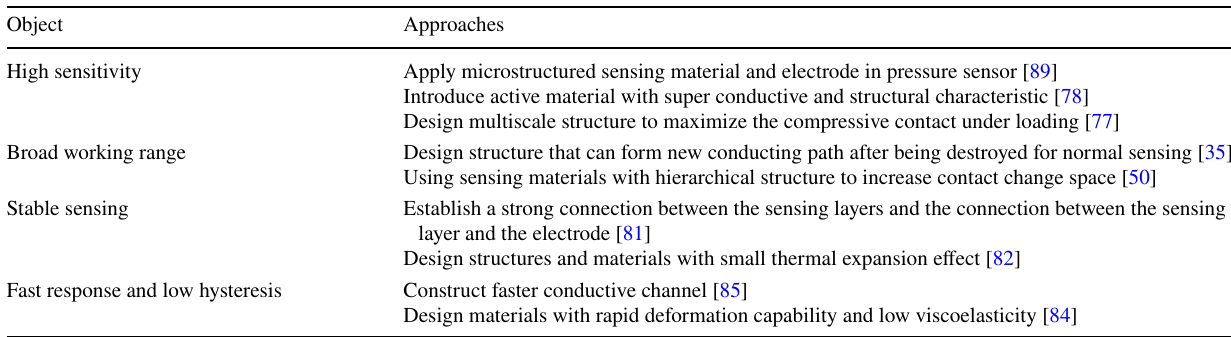
Fast response and low